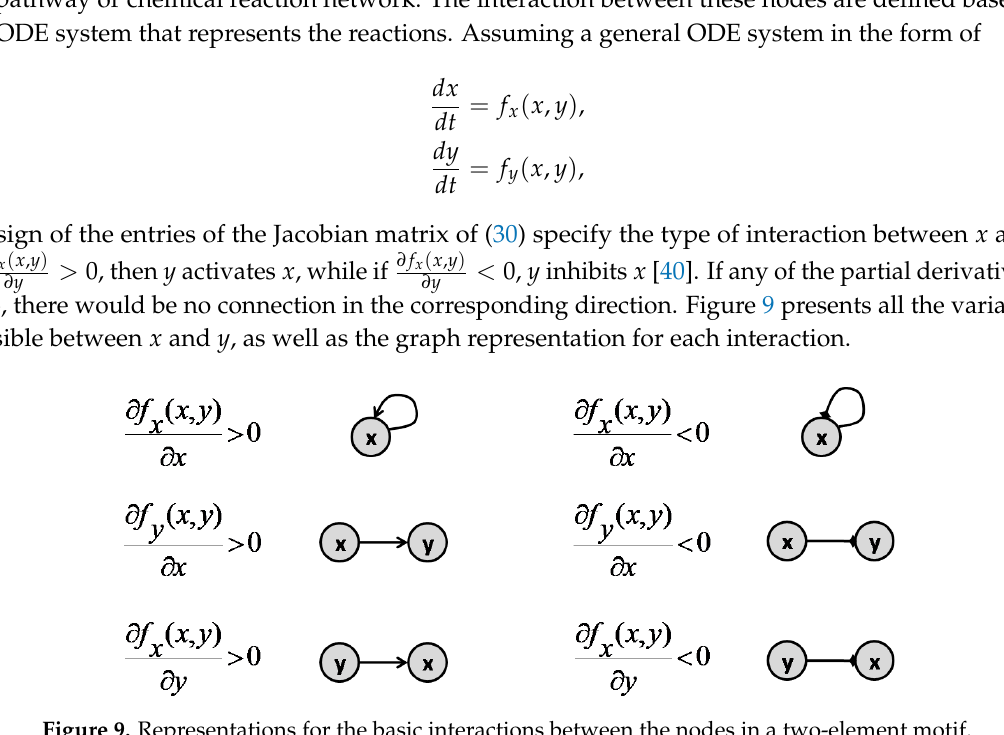
Figure 9. Representations for the basic interactions between the nodes in a two-element